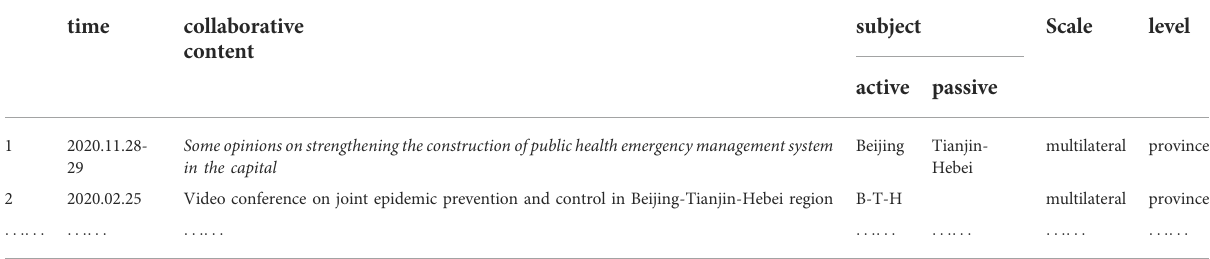
TABLE 2 Text codes and examples related to the emergency cooperation for COVID-19 in the B-T-H region.